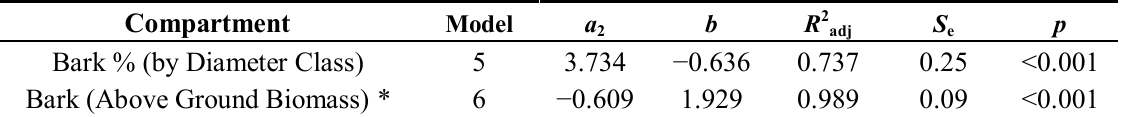
Table 6. Estimated allometric parameters for dry bark percentage by diametric class